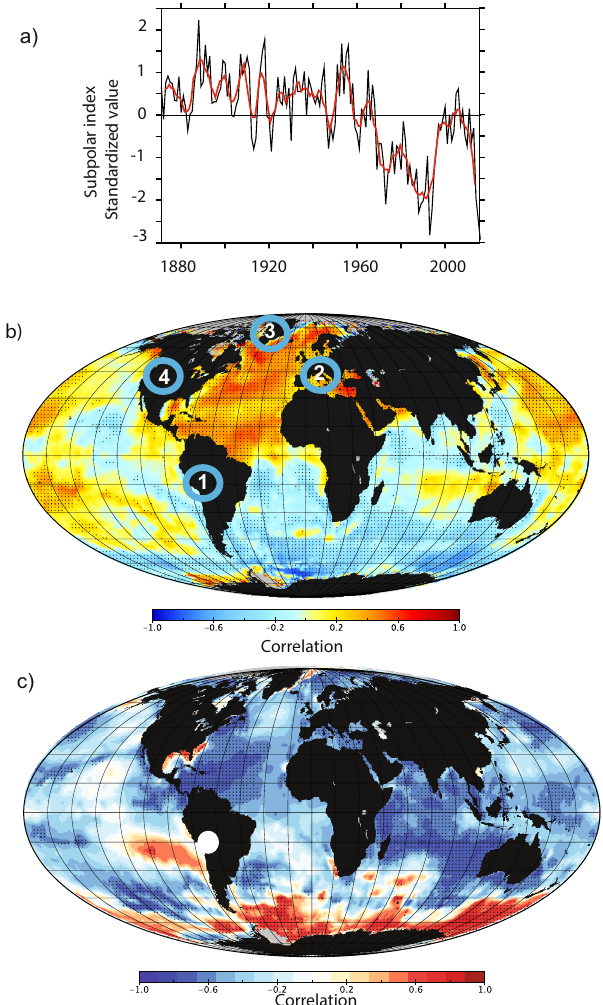
Fig. 3 Global sea surface temperatures (SST) related to the subpolar index and glacier records. a Subpolar index from ref. 17 . In black is the annual mean and in red is the 10-year running mean. b Correlation between detrended SST and HadISST on the Subpolar index shown in panel a that might represent AMOC variations over the same period. Stippling indicates a signi fi cant correlation coef fi cient, i.e. different from zero following a Student t test at the 95% level. Blue circles show locations with new CRE chronologies (see “ Methods ” ), (1) Charquini North and South glaciers (Bolivia), (2) St Sorlin glacier (French Alps), (3) clavering glacier (Greenland), (4) enchantment lakes (Cascade Range, US). c Spatial correlation between October-March mass balance on Bolivian Zongo glacier 33 (white dot) and global SSTs over period 1974 – 2016. Both mass balance and SST data were smoothed with a 9-year running mean (see “ Methods ”